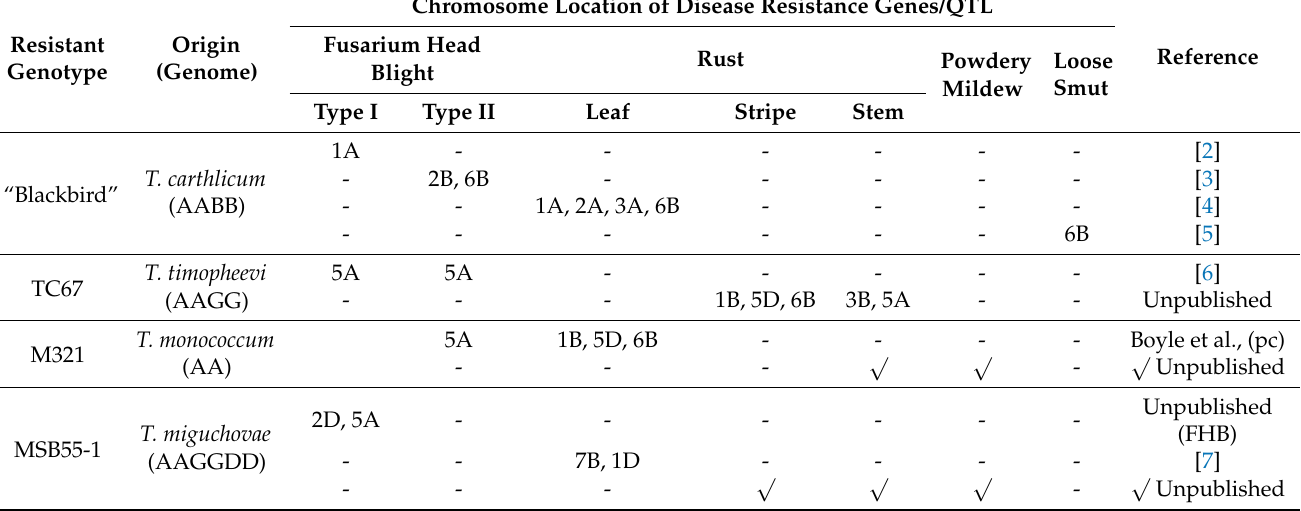
Table 1. Multiple disease resistance in derivatives from wide